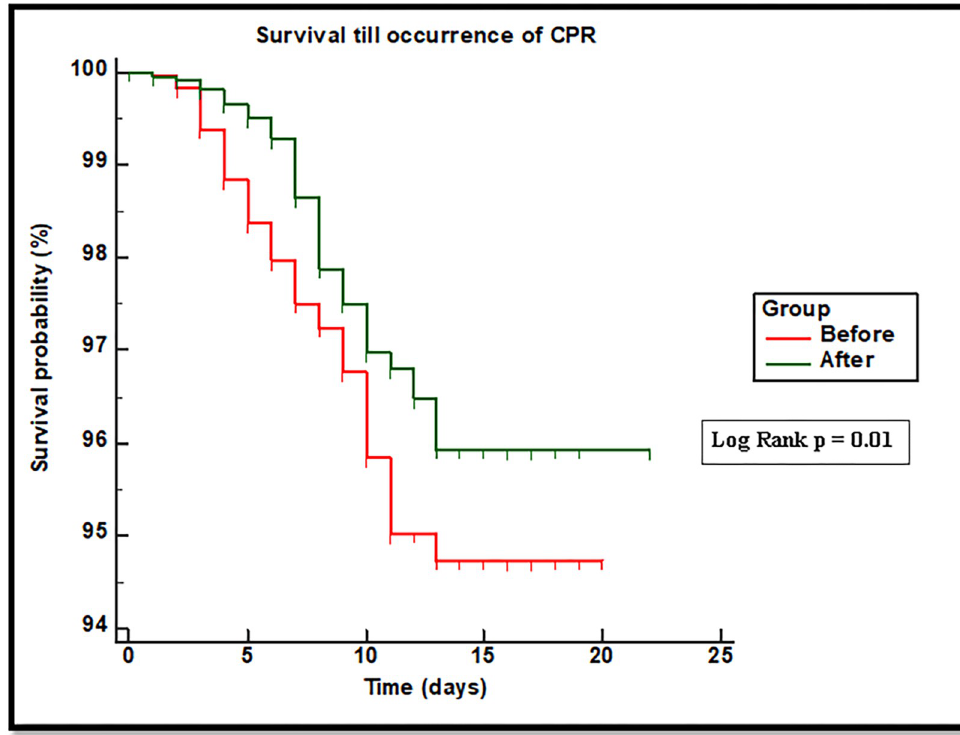
Fig 2. Survival till occurrence of